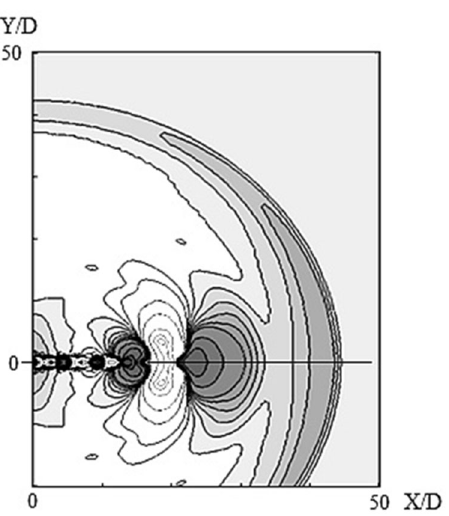
Figure 2. Static pressure distribution in the forming impulse jet [22]. Change in the pressure from 0.4 to 2.2.